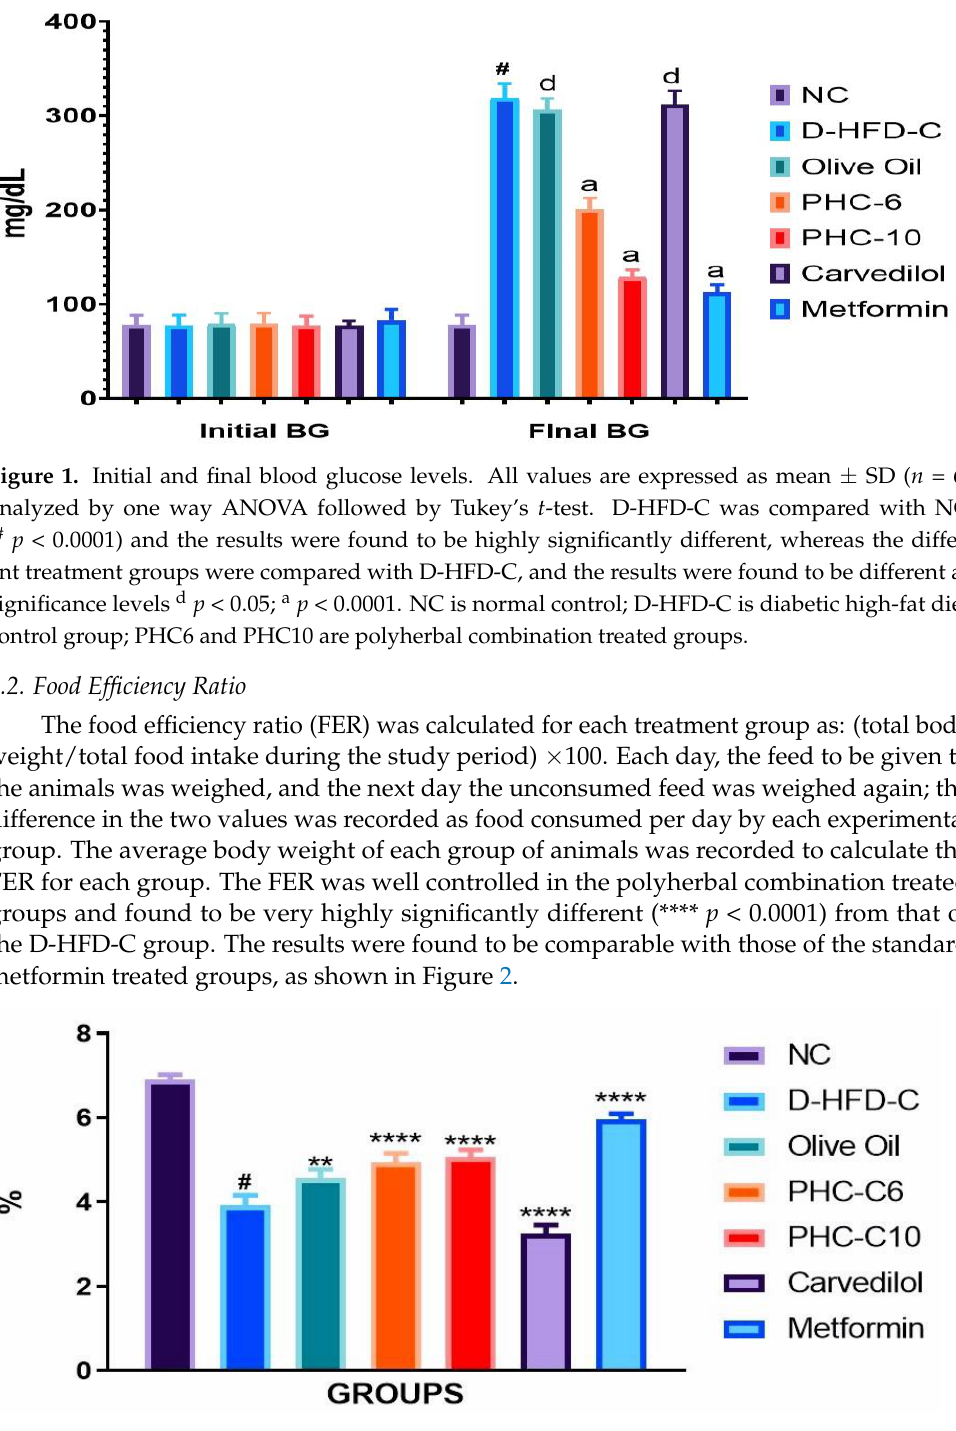
by Tukey’s t -test. D-HFD-C was compared with NC ( # p < 0.0001), and the result was found to be